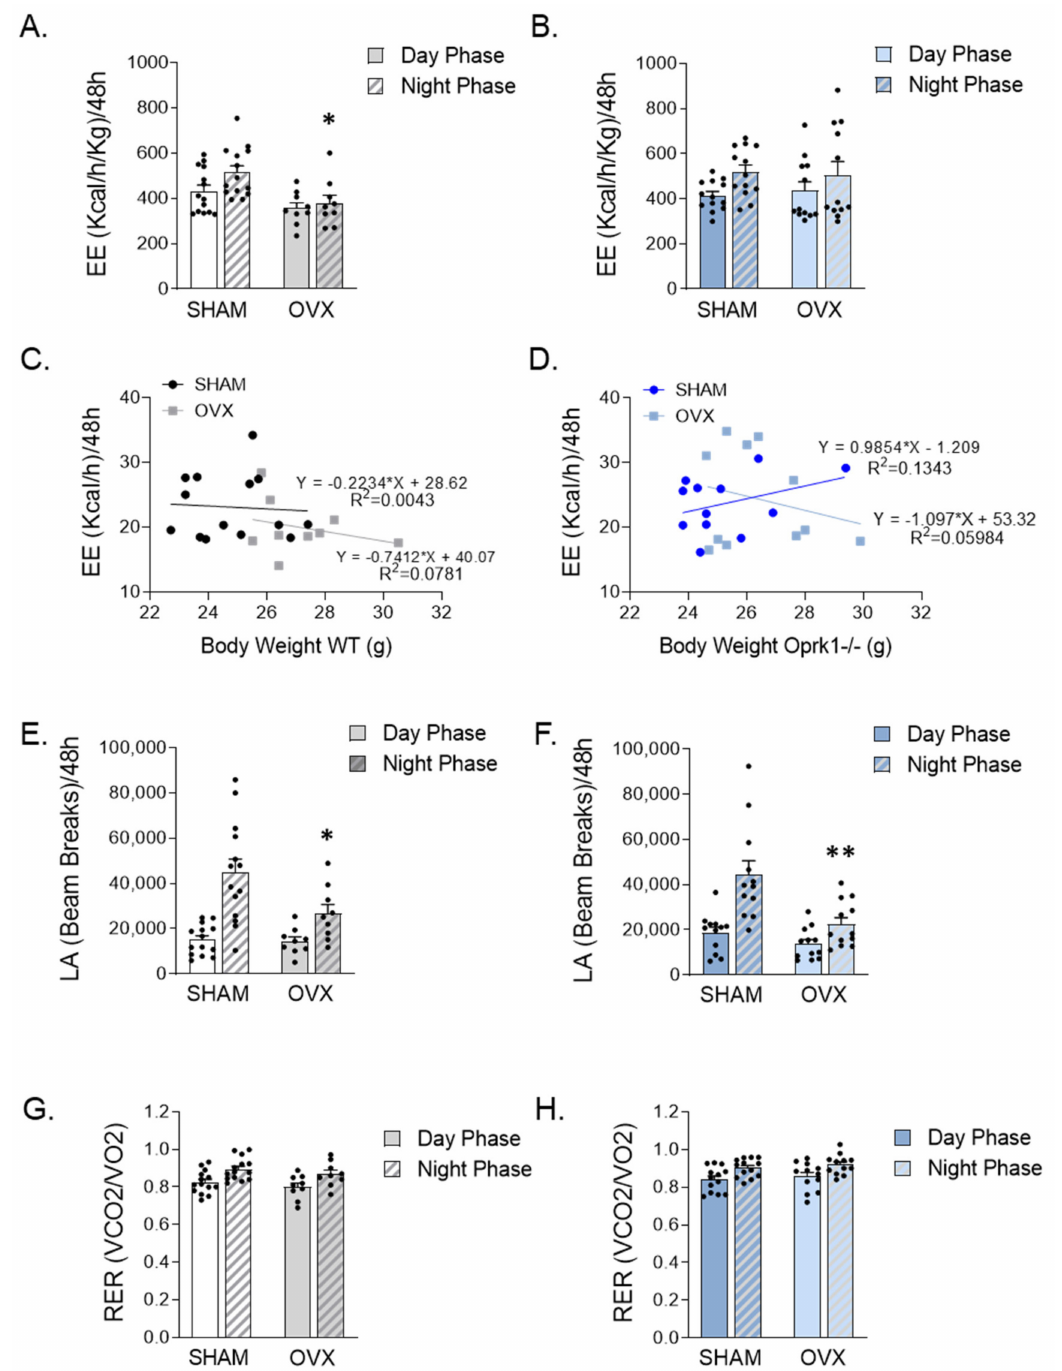
Figure 2. Calorimetric study indicates that Oprk1 − / − mice are insensitive to EE changes in- duced by ovariectomy (OVX). ( A – D ) Total energy expenditure (EE) (Kcal/h/Kg) in ( A ) WT and ( B ) Oprk1 − / − under SHAM and OVX experimental conditions in the light and dark periods during 48 h and relative to body weight (g) in WT ( C ) and Oprk1 − / − ( D ) animals. ( E , F ) locomotor activity (LA) in ( E ) WT and ( F ) Oprk1 − / − during the dark and light phases from 48 h analysis. ( G , H ) respi- ratory exchange ratio (RER) (VCO2/VO2) in ( G ) WT and ( H ) Oprk1 − / − mice considering light and dark phases under SHAM and OVX conditions. Values are expressed as mean ± SEM ( n = 8–12 per group). Unpaired t -test or Mann–Whitney test were used to compare the two groups (SHAM and OVX), indicating significant differences compared to SHAM (*). p < 0.05 (*), p < 0.01